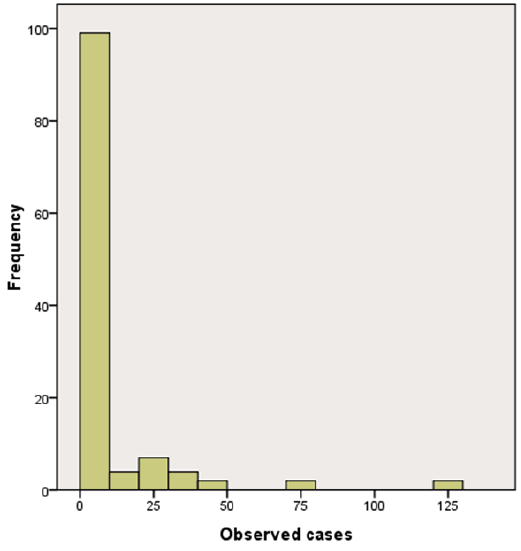
Figure 2. The frequency of monthly observed cases of cholera in Zhejiang during